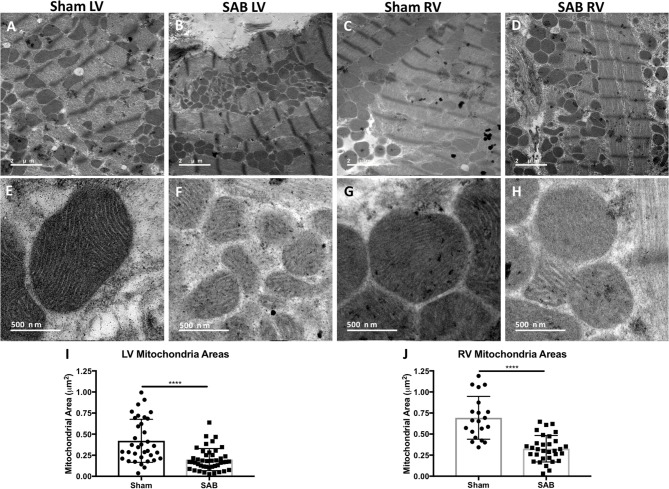
Representative transmission electron microscopy (TEM) images showing reduced average mitochondria area in the left ventricle (LV) and right ventricle (RV) at 2 different magnifications. (A) Low magnification of sham LV, (B) supra-coronary aortic banding (SAB) LV, (C) sham RV, and (D) SAB LV. High magnification showing mitochondrial ultra-sturcture in (E) sham LV, (F) SAB LV, (G) sham RV, and (H) SAB RV. (I) Average LV mitochondrial area, and (J) average RV mitochondrial area. Each dot represents a single mitochondrion.